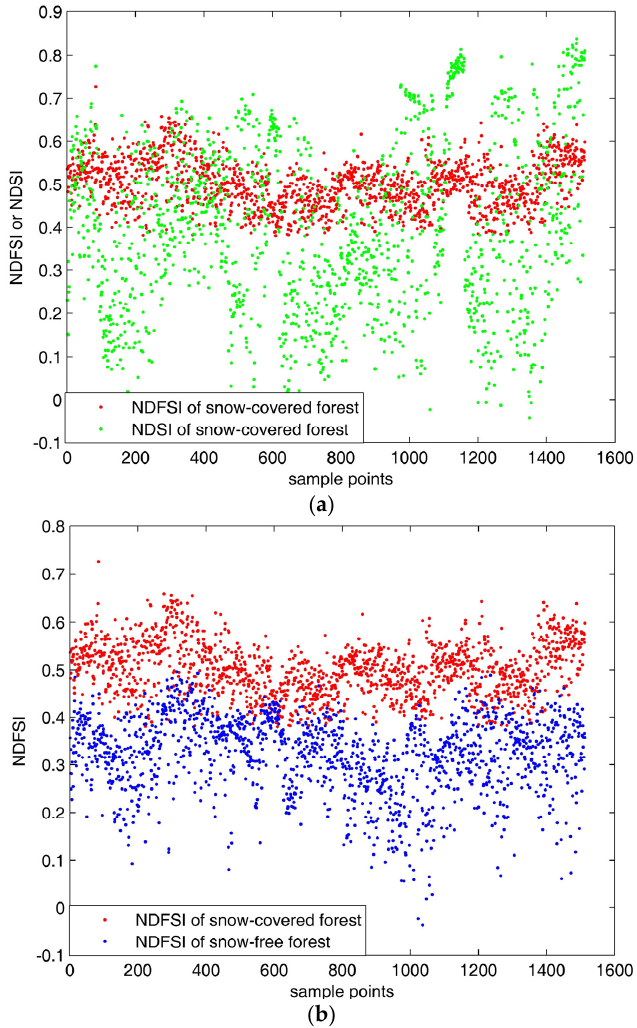
Figure 4. The NDFSI and NDSI of the sample points. ( a ) The NDFSI and NDSI of snow-covered forest; ( b ) the NDFSI of snow-covered forest and snow-free forest.